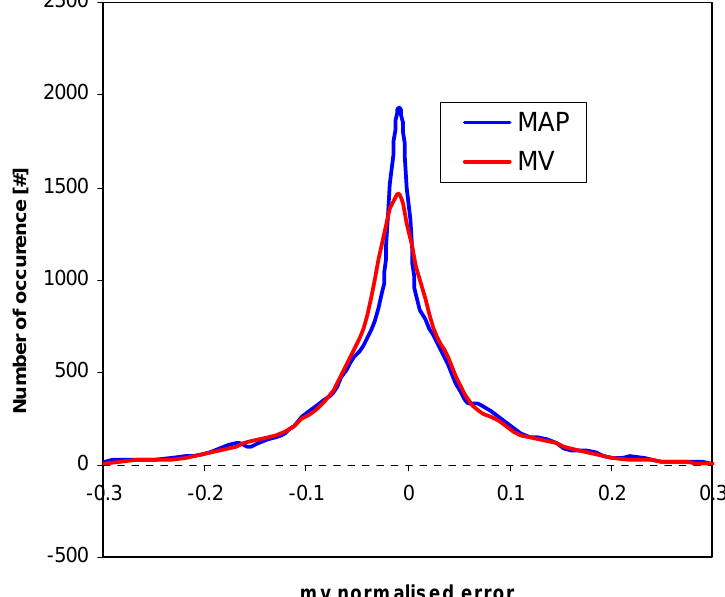
Figure 2 . Comparison between histograms of the m MAP (SEM derived